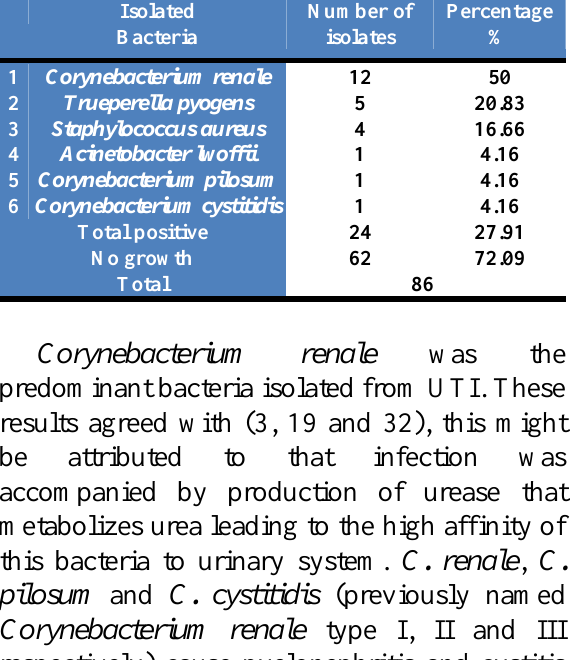
Percentage Number of % isolates